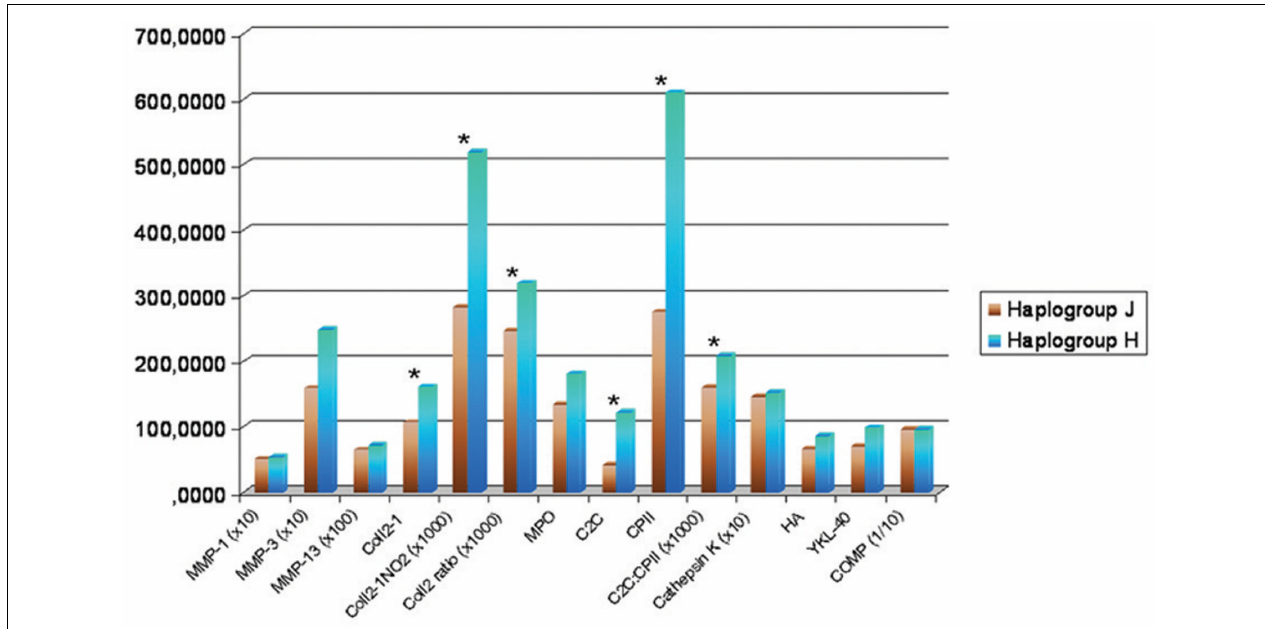
collagen type II and Coll2-1NO 2 = its nitrated form; C2C, a C-terminal neoepitope generated by the collagenase-mediated cleavage of collagen type II triple helix; CPII, the procollagen type II C-terminal propeptide; HA, hyaluronic acid;YKL-40, cartilage glycoprotein 39; COMP, cartilage oligomeric matrix